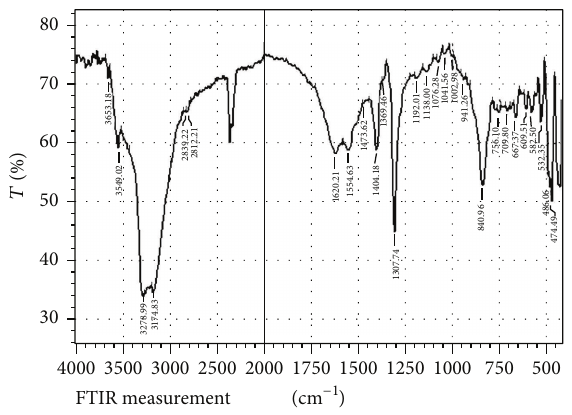
Figure 3: FTIR graph of [Co(NH 3 ) 5 Cl]Cl 2